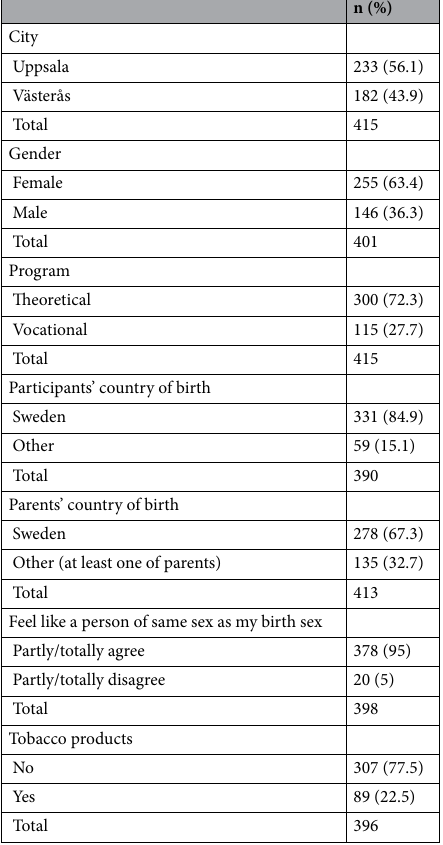
Table 1. Background characteristics of participating first-year high-school